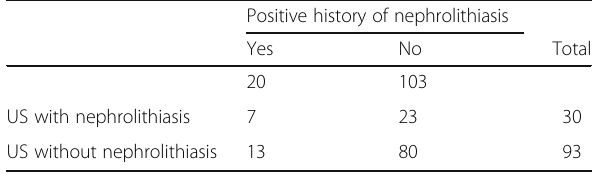
Table 3 Positive history of nephrolithiasis vs ultrasonography